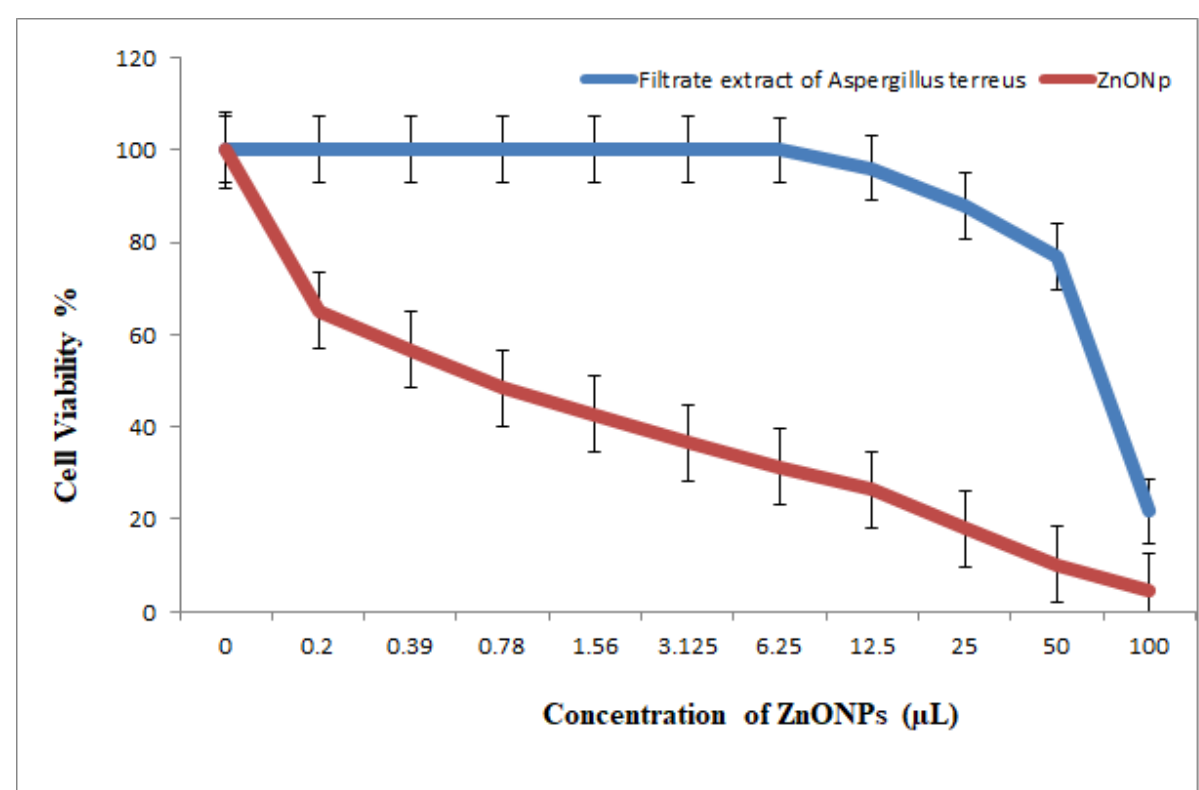
Figure 13. Viability of HCT-116 cells (colon carcinoma cell) (24 h incubation). Treatment with cell filtrate of Asperagillus terreus as control and treatment with zinc oxide biosynthesized nanoparticles (ZnONPs).